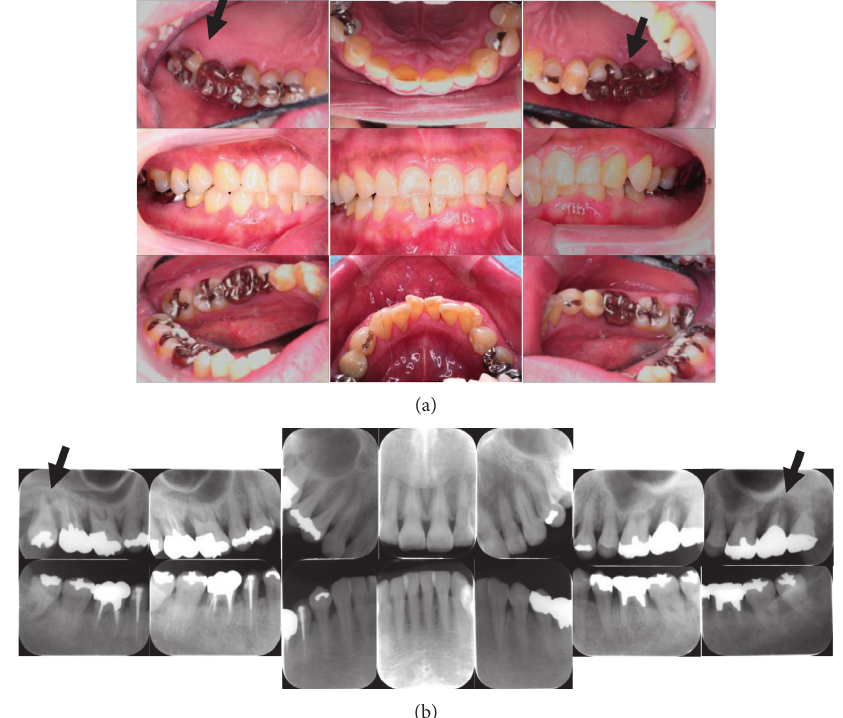
Figure 2: Appearance of the patient’s periodontal tissues at the first visit (a) and radiograph of the periodontium (b). Note the severe alveolar bone resorption and so-called “floating teeth” due to severe periodontitis (b) and moderate gingival inflammation (a). “Floating teeth” were indicated by arrows. In addition, many metal restorations are